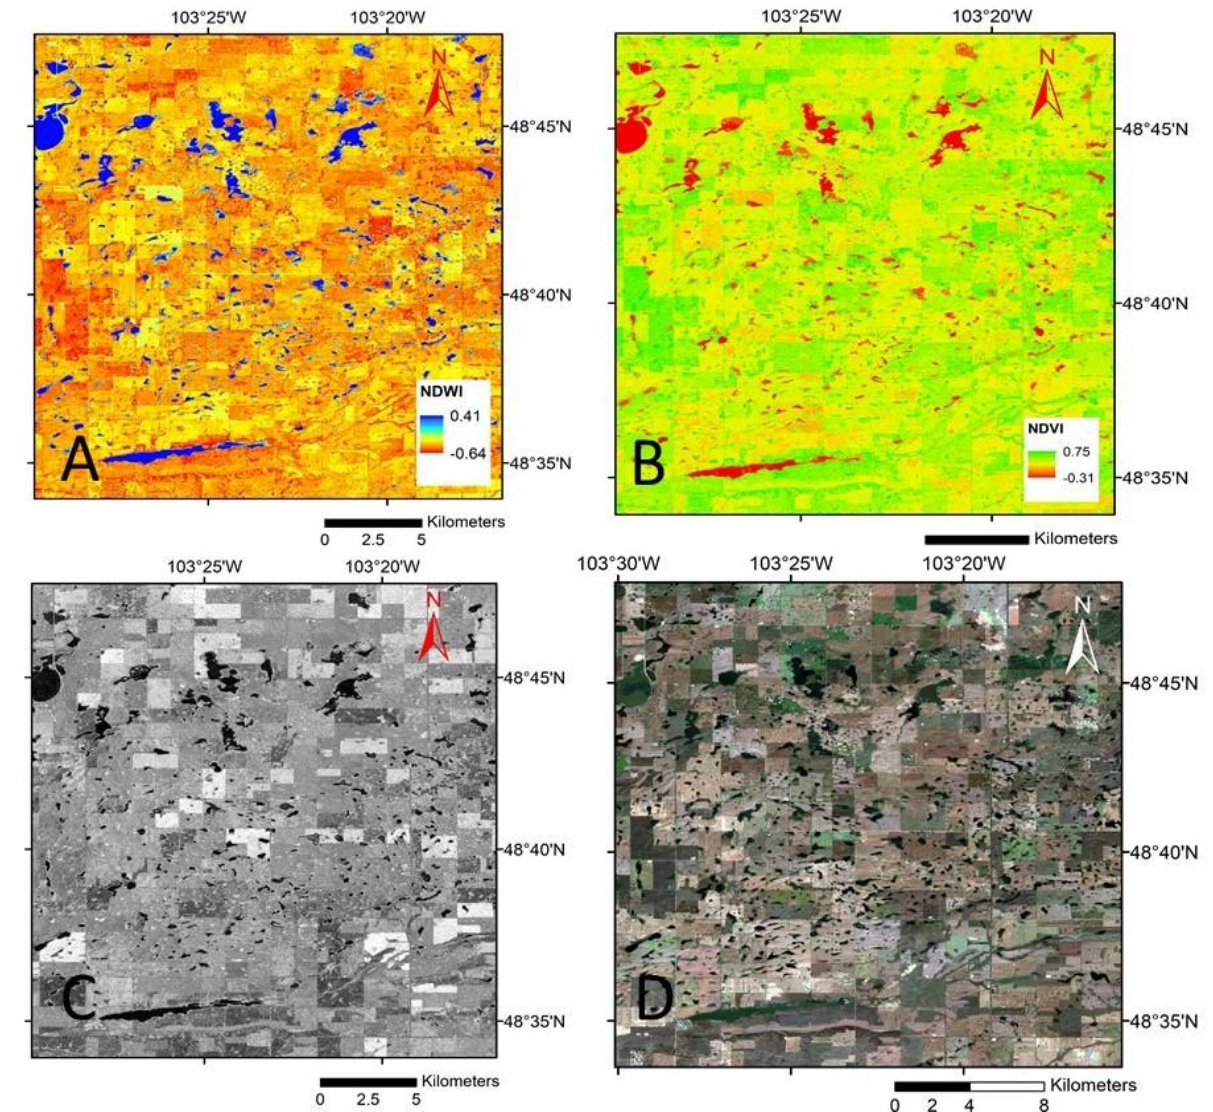
Figure 3. Sentinel-2 derived NDWI ( A ); NDVI ( B ); Sentinel-1 VV ( C ); Sentinel-2 RGB(D).